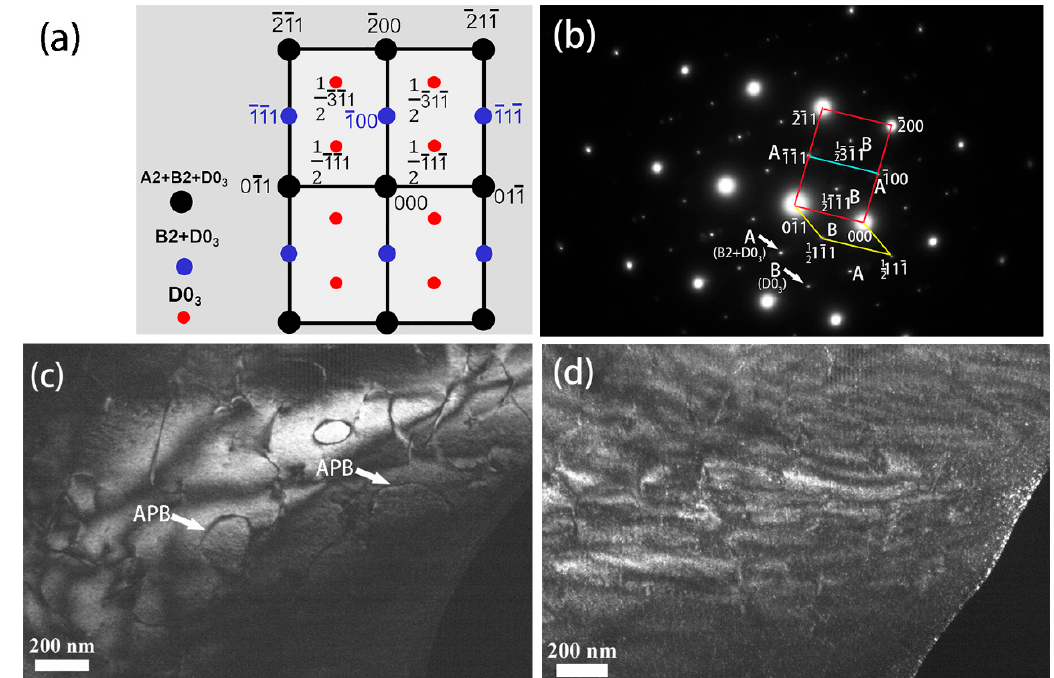
Figure 9. TEM micrographs before deformation along the [011] zone axis. ( a ) Schematic diagram of the SAED patterns; ( b ) SAED patterns. Arrow A designates g = 1/2{200} or {111} reflection, and arrow B designates g = 1/2{111} or 1/2{311} reflection; ( c ) DF image by using 1/2{200} diffraction spot; ( d ) DF image by using 1/2{111} diffraction spot.